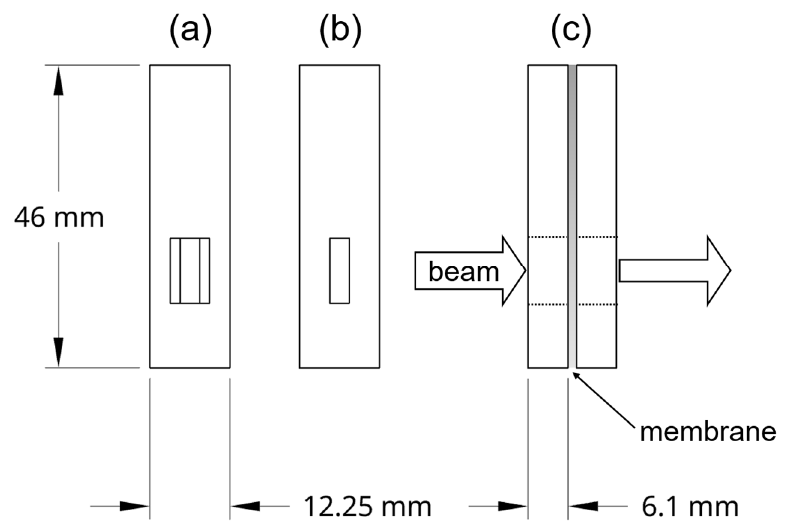
Figure 1. Sketches of ( a ) the outside and ( b ) the inside of the 3D printed cuvette for UV/VIS measurements of membranes, and ( c ) the application during measurements.